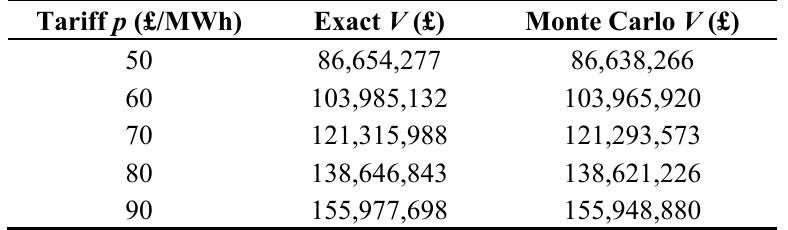
Table 8. Present value of a 50 MW wind farm under a feed-in